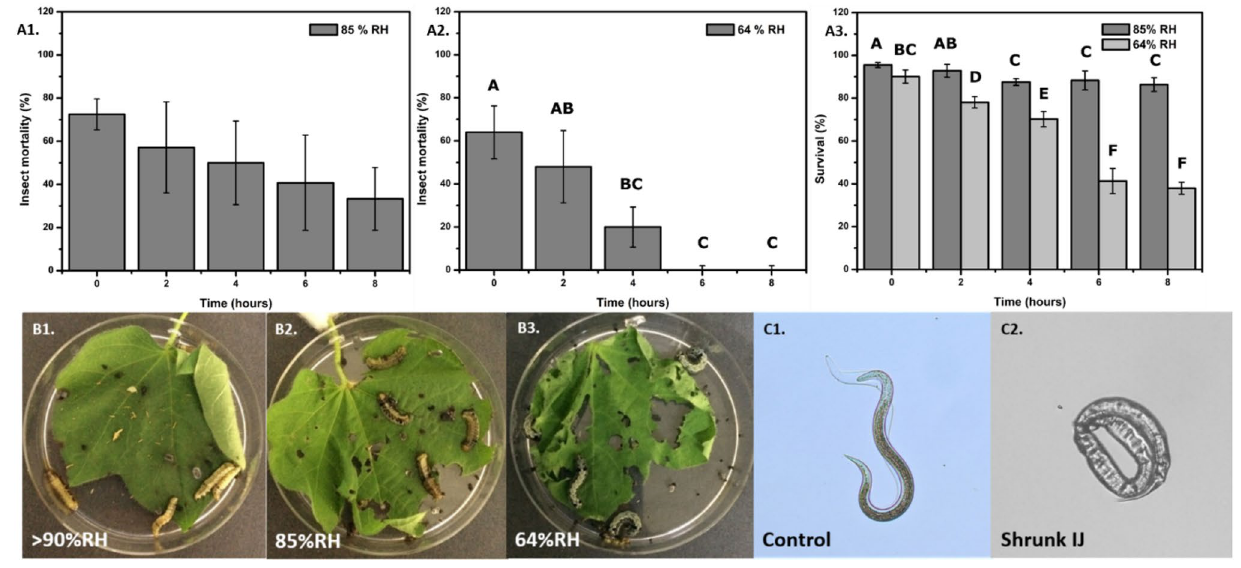
Figure 3. Insect mortality in rapidly desiccated S. carpocapsae at 85 and 64% RH. Insect mortality of late 4th instar larvae of Spodoptera littoralis against S. carpocapsae applied at a concentration of 5000 ± 150 IJs/leaf and incubated for 48 h at 85%RH ( A1 ) and 64%RH ( A2 ). ( A3 ) Nematode survival on leaf at 85 and 64% RH over 0, 2, 4, 6 and 8 h. ( B1 – 3 ) Images of experimental set up. ( C1 , 2 ) Images exhibiting fresh/control and shrunk S. carpocapsae IJ on leaf after 1.5 h of RD under 44% RH.